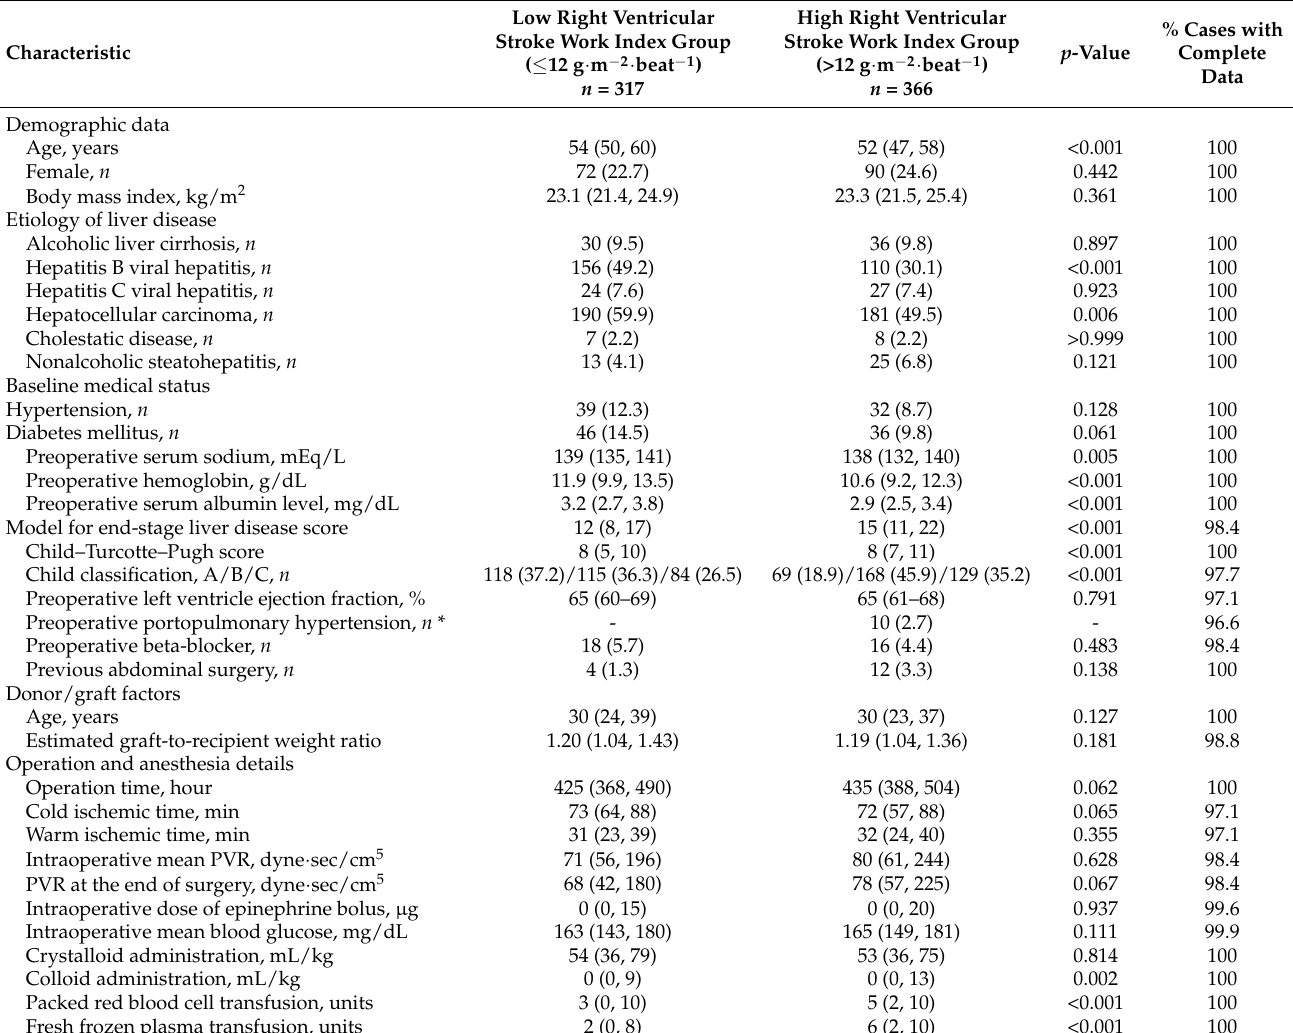
Table 1. Comparison of patient characteristics and perioperative parameters between low and high time-weighted mean right ventricular stroke work index (RVSWI)